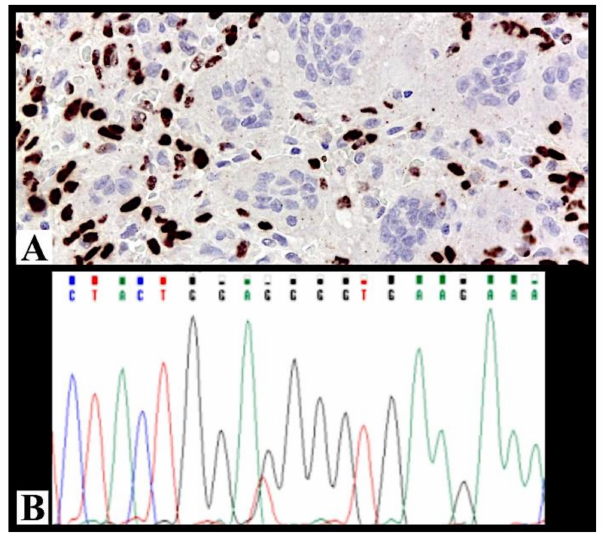
Figure 1. ( A ) Strong and diffuse immunohistochemical nuclear positivity for H3F3A in case 10 (immunohistochemistry for H3F3A, 200 × magnification). ( B ) Molecular analysis of case 11 confirmed the presence of the mutation in heterozygosity.